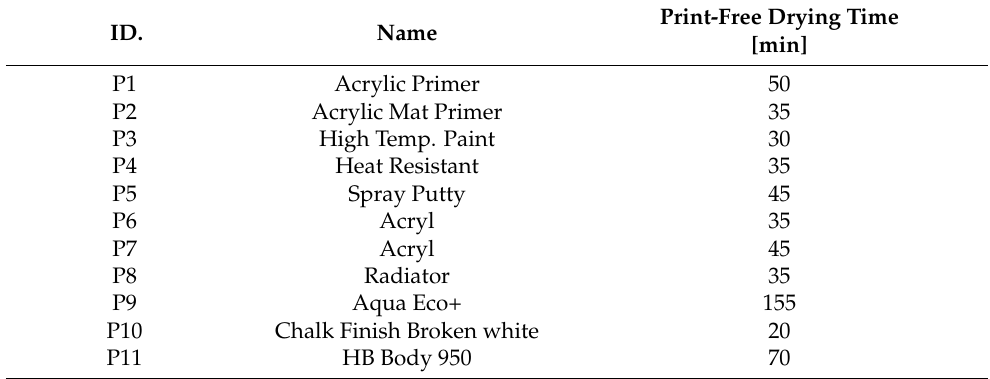
Table 7. Print-free drying